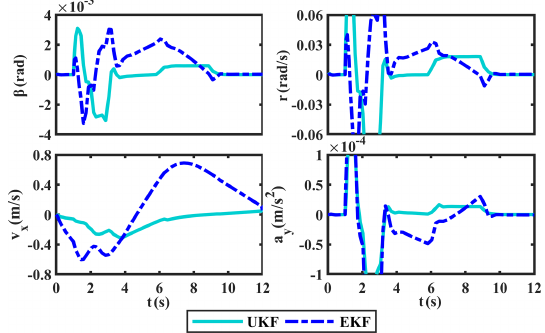
Figure 15. The absolute error curve of β , r , v x , and a y under fish- hook manoeuver test II.